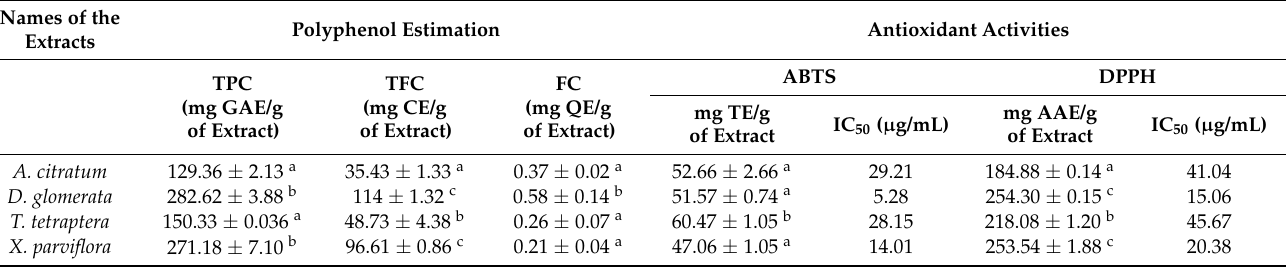
Table 4. Polyphenol content estimation and antioxidant activities of spice